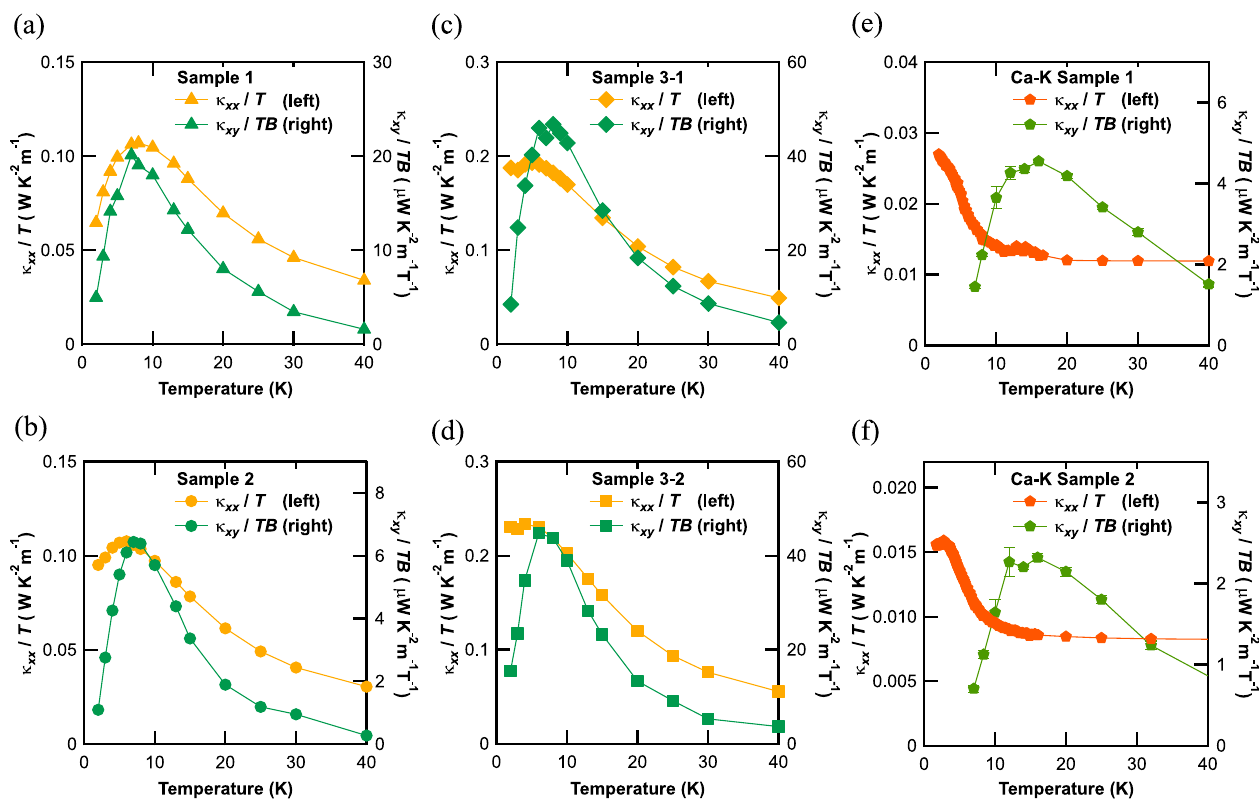
=T (left axis) and that of κ =TB (right axis) at 15 T of all Cd-K samples (a) – (d) and Ca-K xx xy